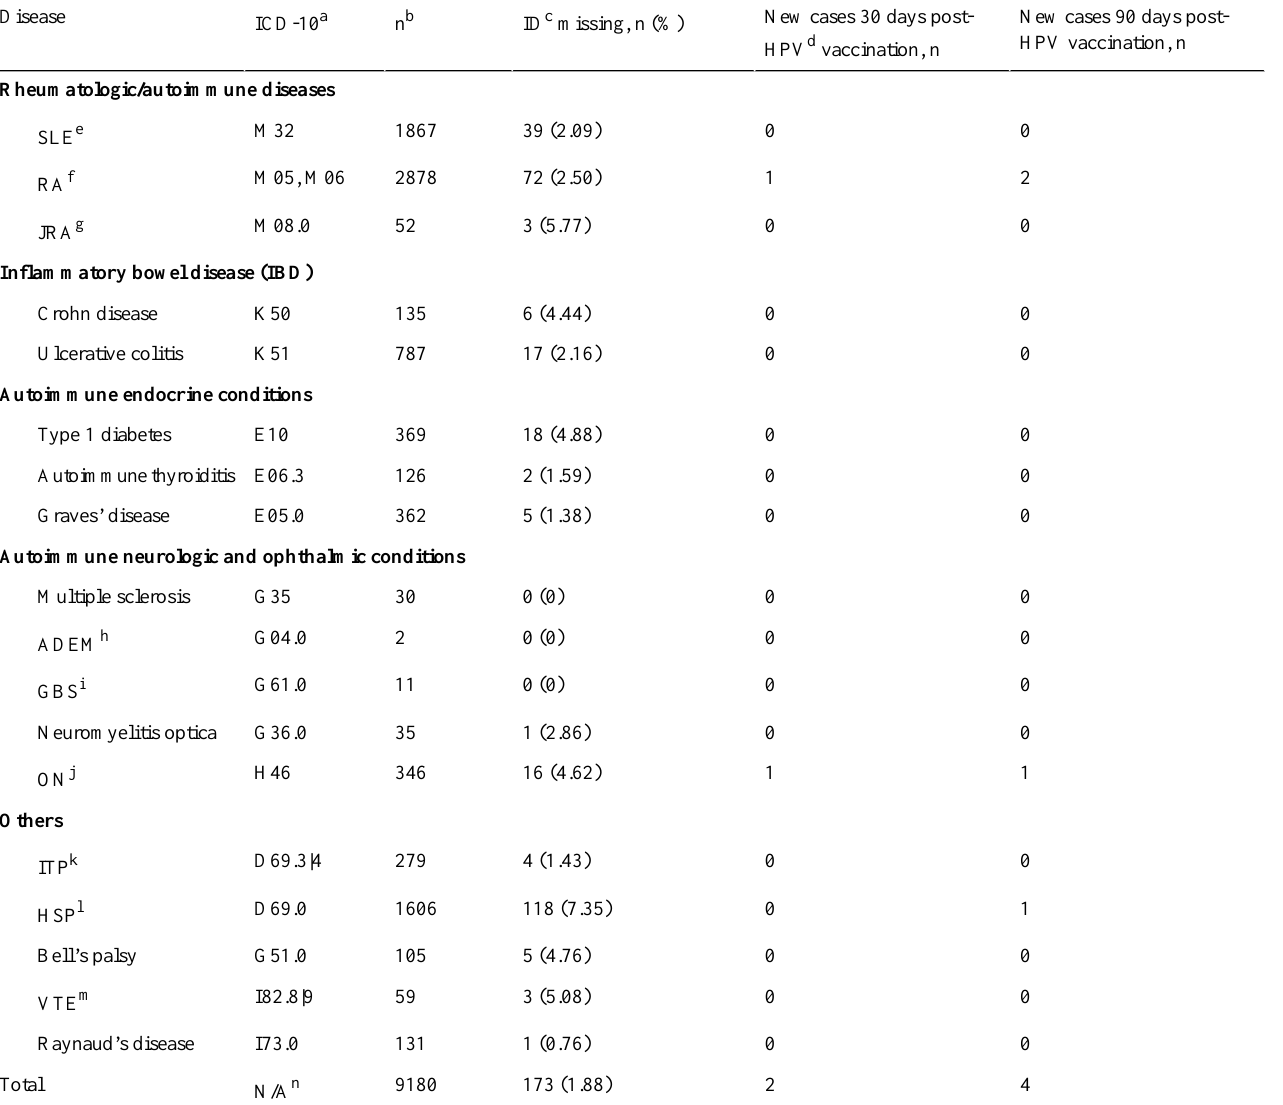
Table 3. Outcomes among women aged 9-45 years recorded in electronic medical